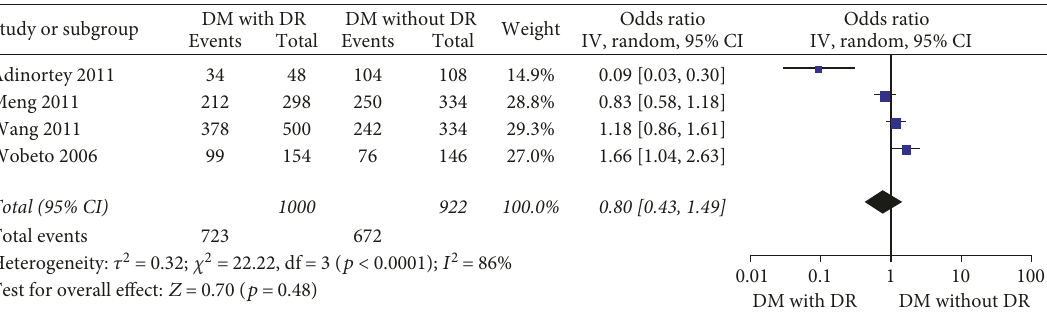
Figure 3: Forest plot for meta analysis comparing DR with DWR in allele model (T versus C).